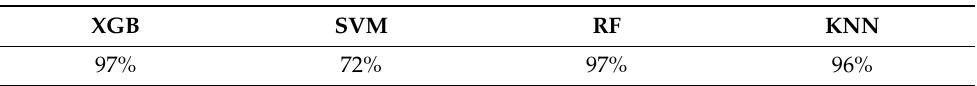
Table 9. Overall testing accuracy of different machine learning models for detection of mouse ear hawk-weed foliage at 0.65 cm/pixel at the study site. XGB SVM RF KNN